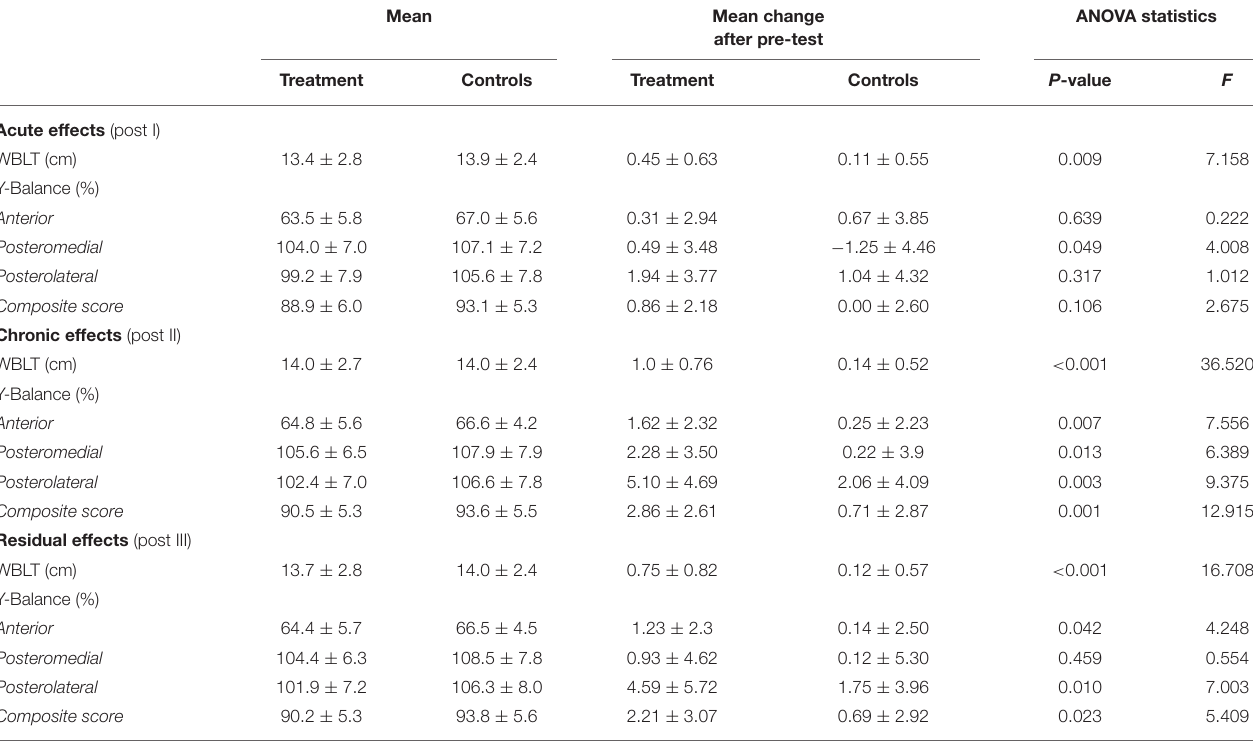
TABLE 3 | Mean and statistics of acute, chronic, and residual